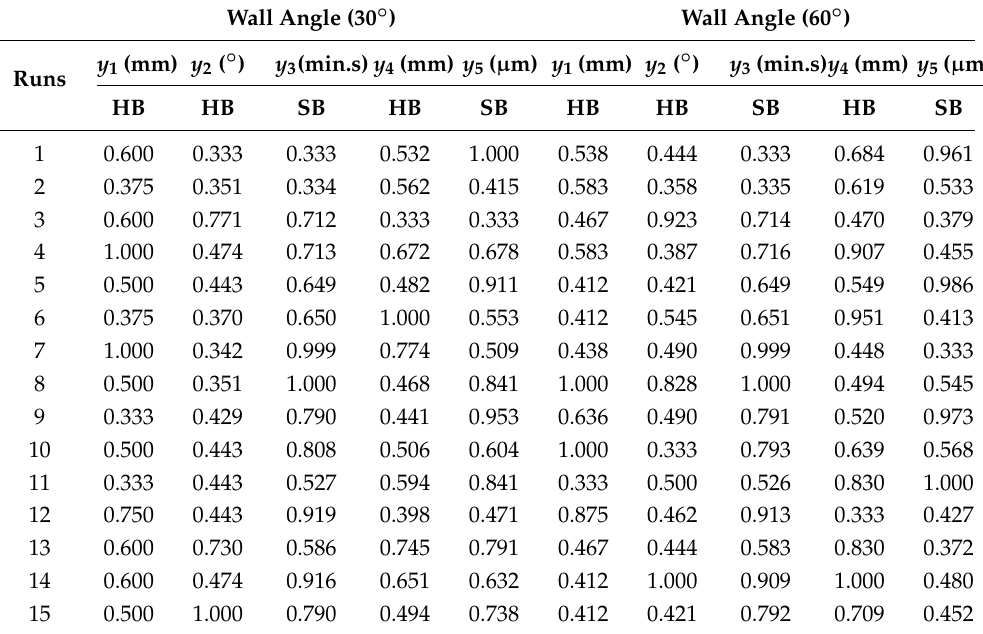
Table 7. Estimated values of the grey relational coefficient.